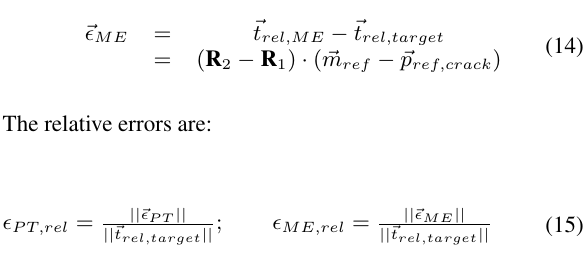
Figure 6. (a) Triangular mesh (reference state) with the red separation line, blue triangle center points and blue connections to the perpendicular foots (green points) on the line; (b) mesh (deformed state) and error vector field for the model of PT (scale factor: 10) for 10° relative rotation; (c) mesh (deformed state) and error vector field for ME (scale factor: